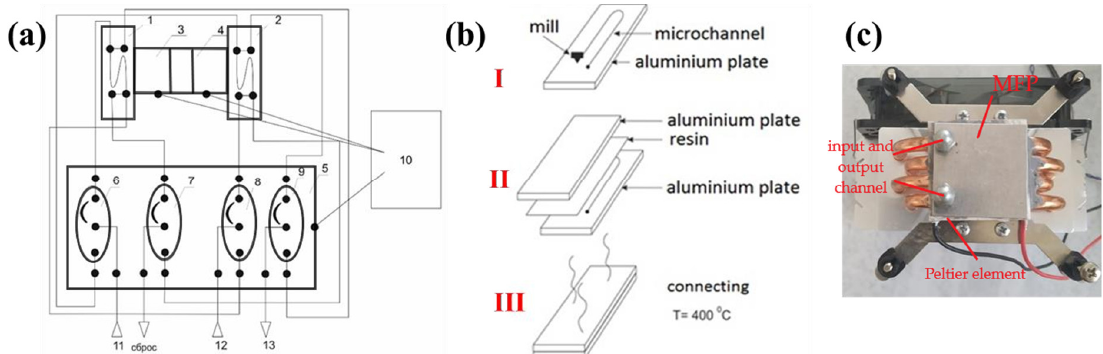
Figure 1. ( a ) Shows the schematic diagram for as-prepared MFP. The notations are as follows: 1, 2— microfluidic preconcentrators; 3, 4—Peltier elements; 5—flat aluminum plate; 6–9—3/2